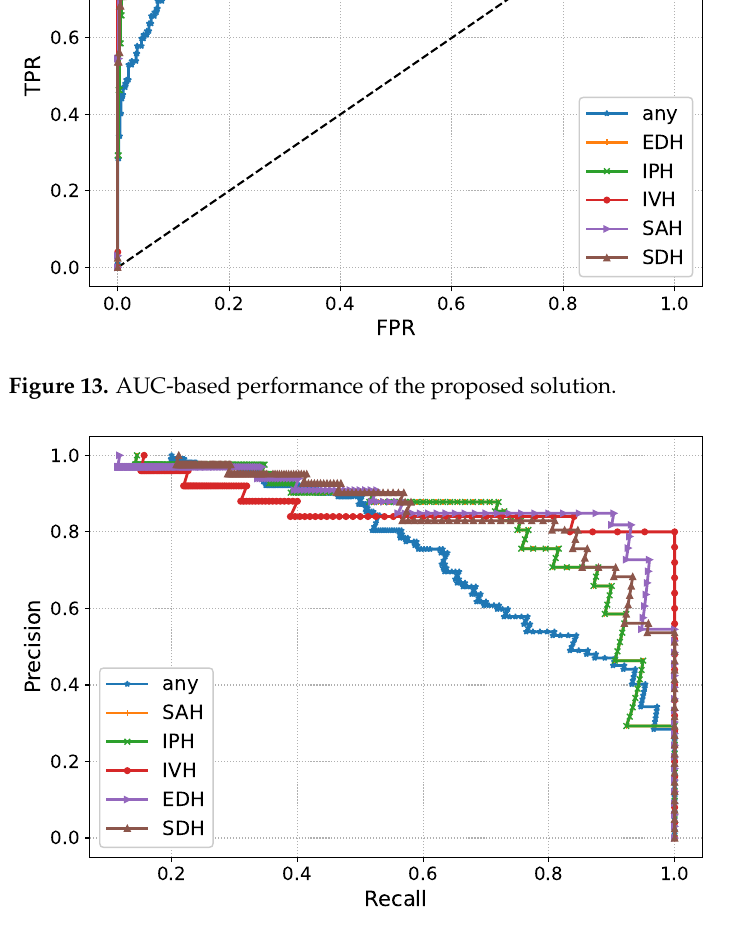
Figure 14. Proposed solution’s performance based on